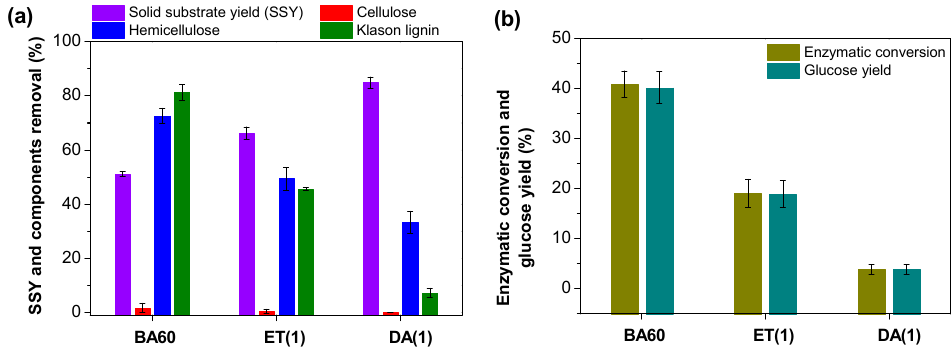
Figure 1. Effects of different pretreatments (BA60, ET(1), and DA(1)) on the ( a ) components removal and ( b ) enzymatic hydrolysis efficiency. Experiments including pretreatment, enzymatic hydrolysis, and corresponding measurements were repeated twice. The measurement errors were the standard deviations of the replicate analyses. To simplify the discussion, the BA pretreatment conducted with a content of 60 wt % BA in pretreatment liquor at 90 °C for 30 min was abbreviated as BA60 pretreatment. Under same pretreatment temperature and time, the ET and DA pretreatments were also abbreviated as ET(1) and DA(1), respectively, while the molar amounts (0.51 mol) of ethanol and hydrogen ions were both equivalent to that of BA used in BA60 pretreatment.